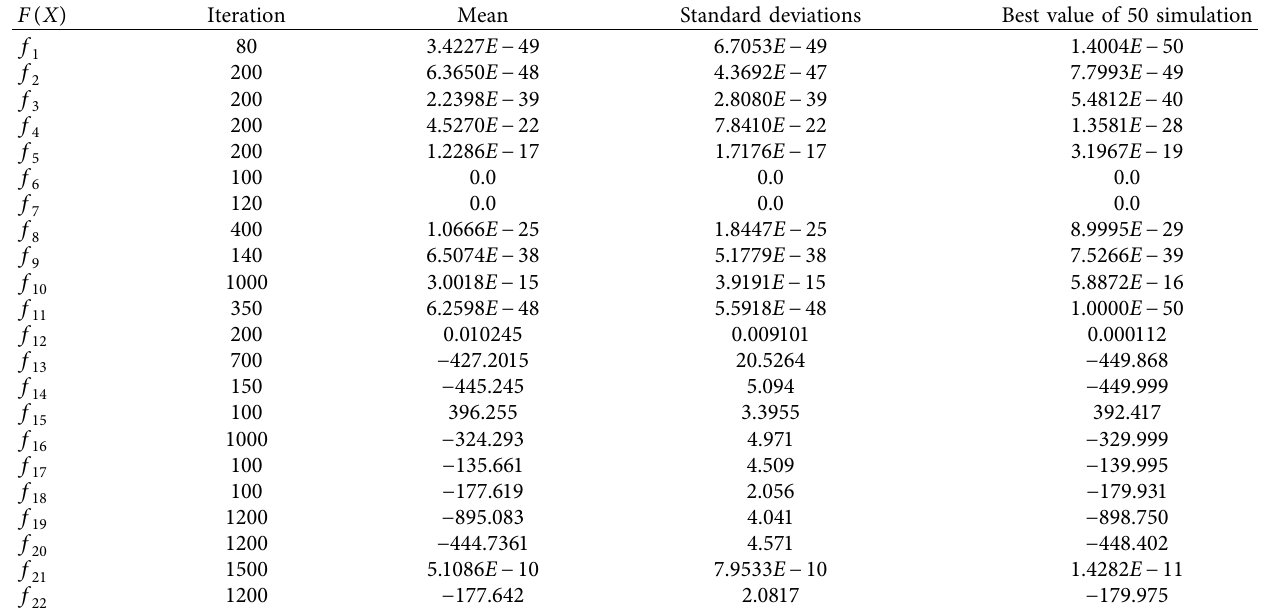
Table 3: Performance of the GB-PSO